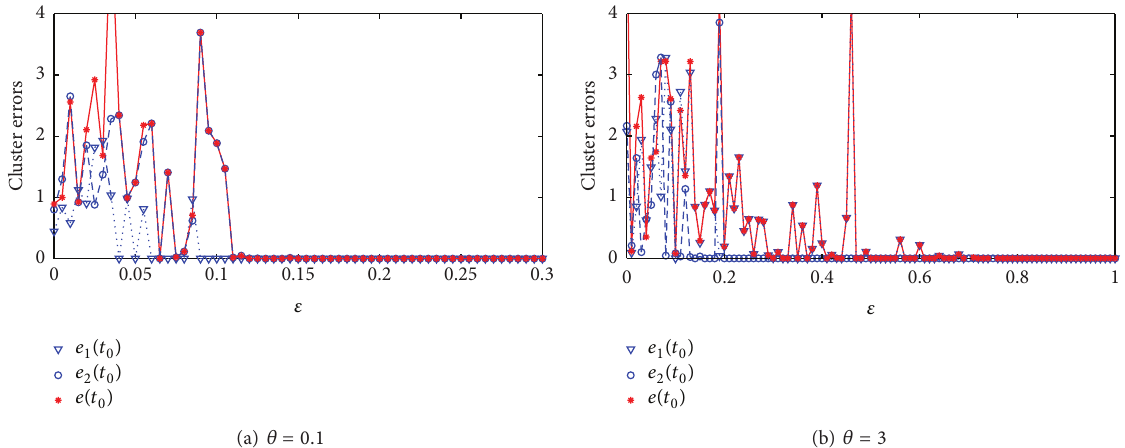
Figure 3: Dependence of the cluster errors 𝑒 1 (𝑡 0 ) , 𝑒 2 (𝑡 0 ) , and 𝑒(𝑡 0 ) on the coupling strength 𝜀 for the network (19) with the coupling matrix